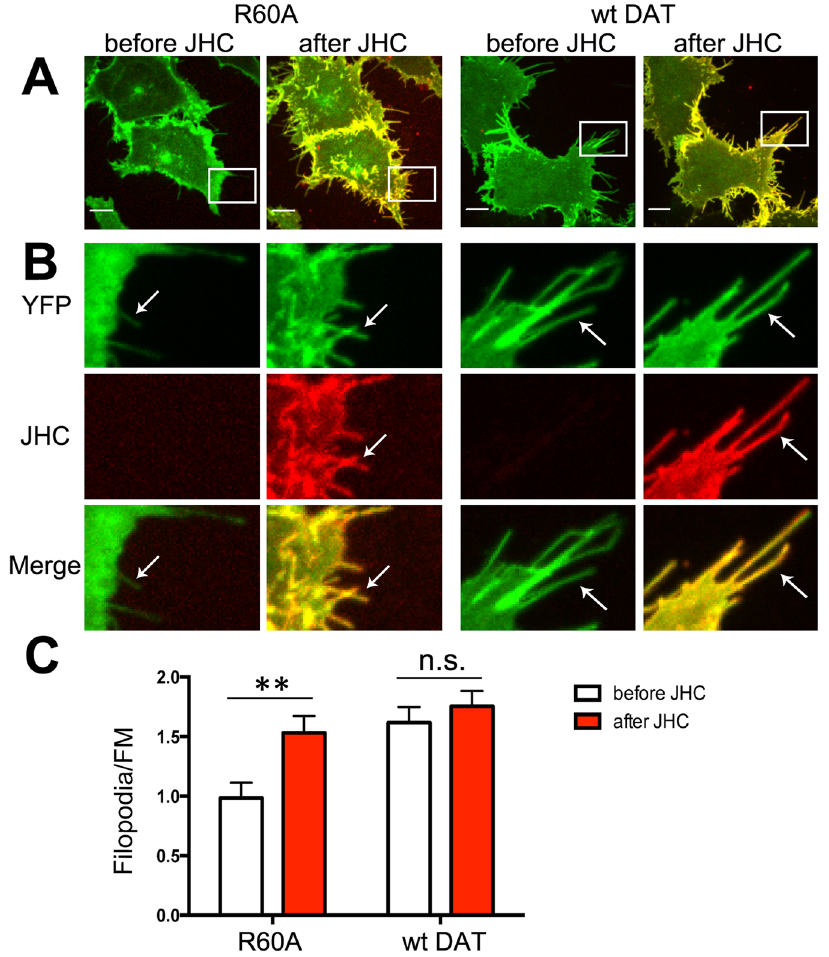
Figure 2. Binding of JHC1-64 increases the concentration of R60A in filopodia of HEK293 cells. ( A ) Cells transiently expressing YFP-HA-DAT or the R60A mutant were incubated with 100 nM JHC1-64 for 30 min at RT. Live-cell imaging was performed through 515 nm (YFP, green ) and 561 nm (JHC1-64, red ) filter channels. Maximal z-projections of 5 consecutive x-y-confocal planes are shown. Scale bars, 10 μ m. ( B ) Insets represent high magnification images of the regions marked by the white rectangle in ( A ). Arrows point to representative filopodia. ( C ) The Filopodia/FM ratios of mean intensities of the YFP fluorescence were calculated as described in the “Methods”. Results are shown as mean values ( ± SEM, n = 10). ** p <